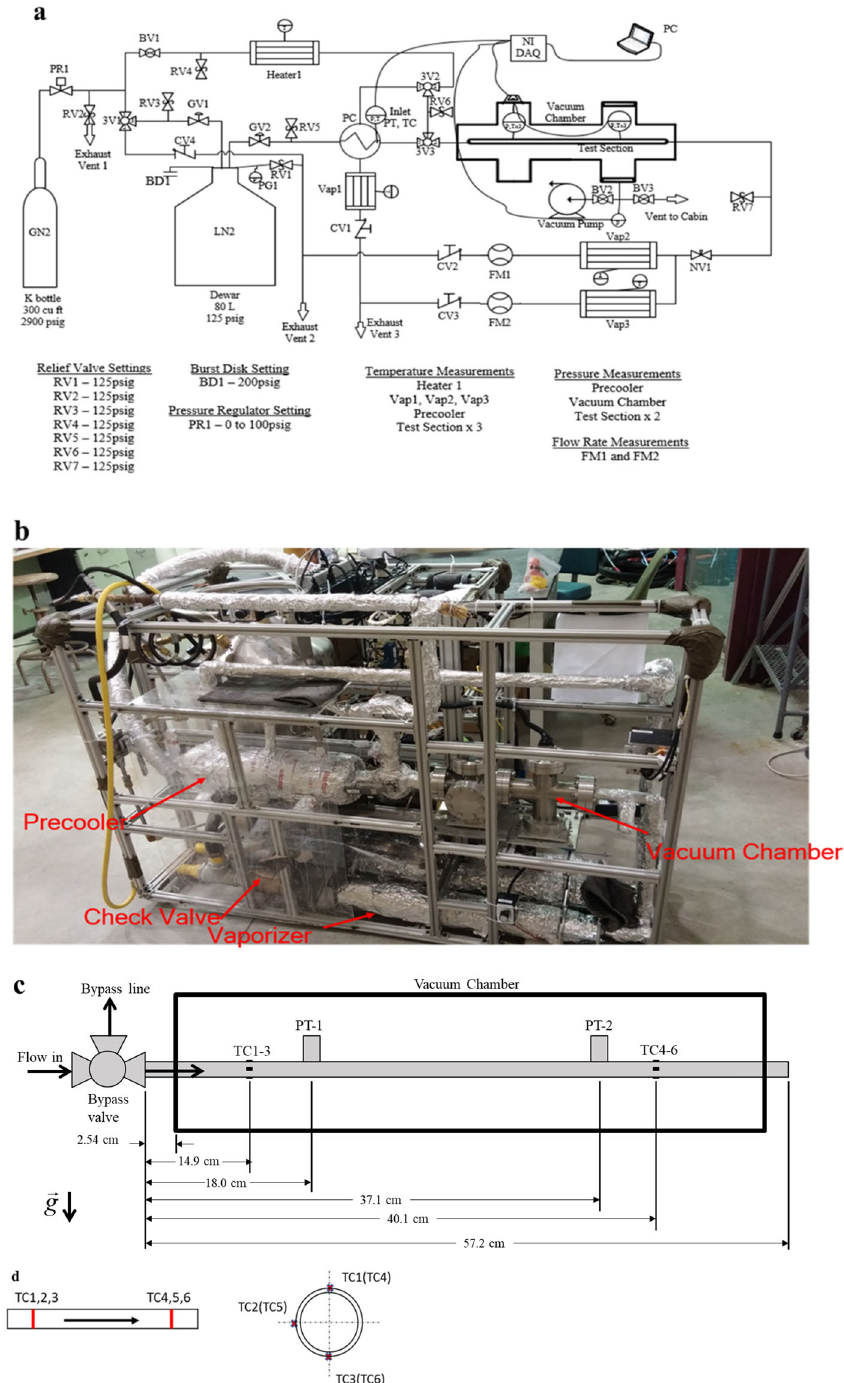
Fig. 6 Experimental system. a Fluid system schematic. The valves and important components of the fl uid network. Relief valve settings, the burst disk setting, and pressure regulator settings are also included. BD burst disk, BV ball valve, CV check valve, DAQ data acquisition unit, FM fl ow meter, GN2 gaseous nitrogen, GV globe valve, LN2 liquid nitrogen, NV needle valve, PC pre-cooler, PG pressure gauge, PR pressure regulator, PT pressure transducer, RV relief valve, TC thermocouple, Vap vaporizer, 3V three-way valve. b Photograph of experimental system. c Test section dimensions and details. d Schematic showing the placement of six TCs. There are two TC stations, one upstream and one downstream. Three TCs are placed at each TC station in the form of top, side, and bottom